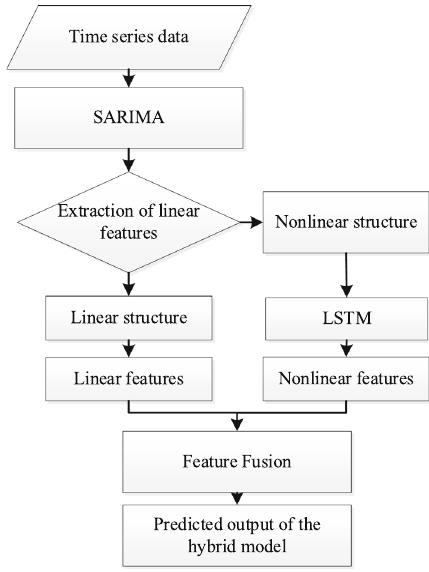
Fig. 3 Structure of hybrid prediction